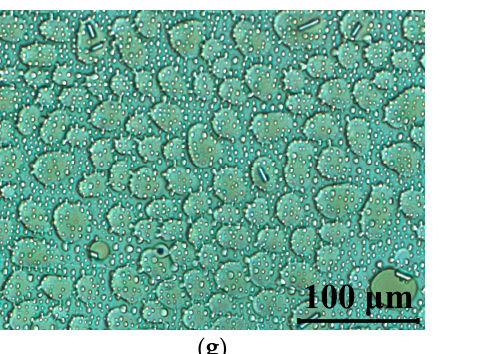
Figure 6. Polarized optical micrographs of cells filled with 5005 mixture observed between crossed polarizers: ( a ) fresh sample; and ( b – h ) under UV light ( λ = 375 nm, P = 40 mW/cm 2 ) during: ( b ) 10 s, ( c ) 60 s, ( d ) 120 s, ( e ) 5 min, ( f ) 10 min, ( g ) 60 min, ( h ) 120 min. The LC’s optical axis was rotated at 45° with respect to the polarizer orientation.